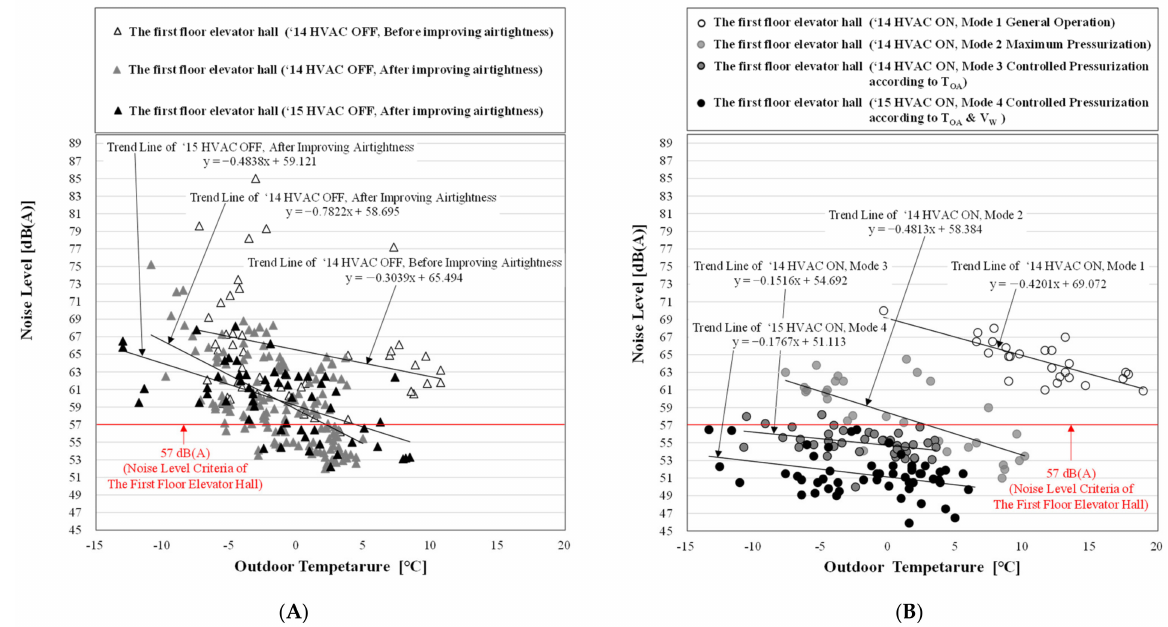
Figure 11. ( A ) Changes in NL for the first floor elevator hall with improved airtightness. ( B ) Noise distribution of elevator hall on the first floor according to different HVAC pressurization modes. Table 4. Average NL on the 1st and 47th elevator halls before and after completion of airtightness improvement work, when HVAC systems are